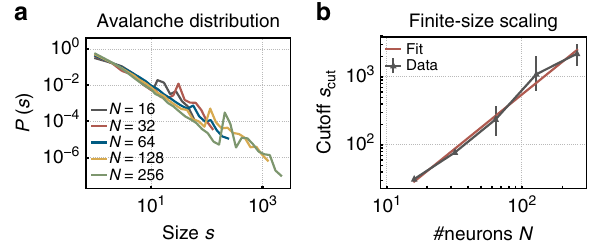
Fig. 3 Finite-size scaling is assessed using a software implementation with varying system size N . a Exemplary avalanche size distributions Pð s Þ follow a power law for any tested N (degree of input K ext / N = 1/4). b As expected for critical systems, the cutoff s cut scales with the system size. The scaling exponent is 1.6 ± 0.2.